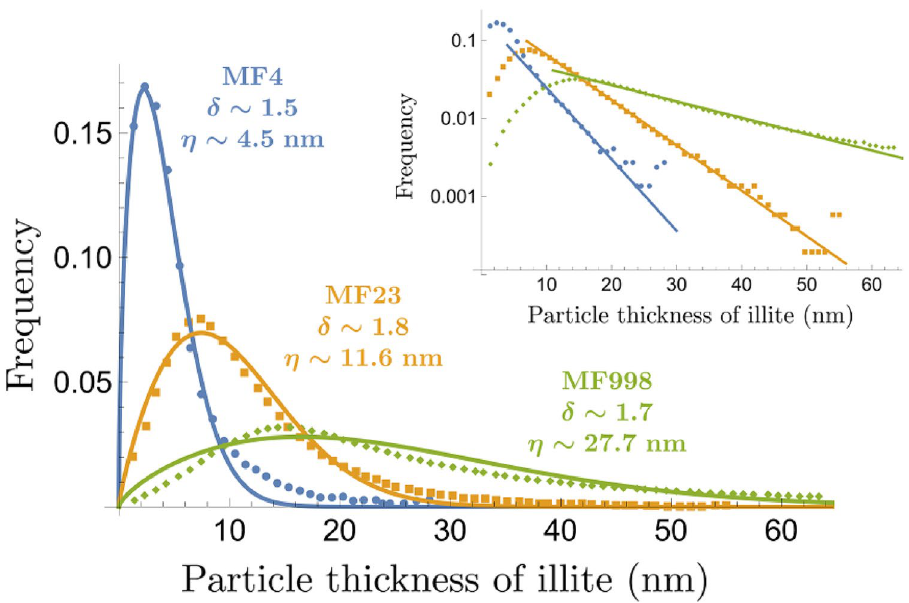
Figure 2. Clay particle thickness distributions for illites in shale from the Glarus Alps 5 . Metamorphic grade increases from sample MF4 (blue) to MF23 (orange) and to MF998 (green). Solid lines are fits to the Weibull distribution given by Eq. (22), where δ represents the effective dimensionality of the clay particles and η represents the characteristic thickness. The inset shows a log-linear plot of the distributions, indicating nearly exponential tails in the clay particle size distribution for all the